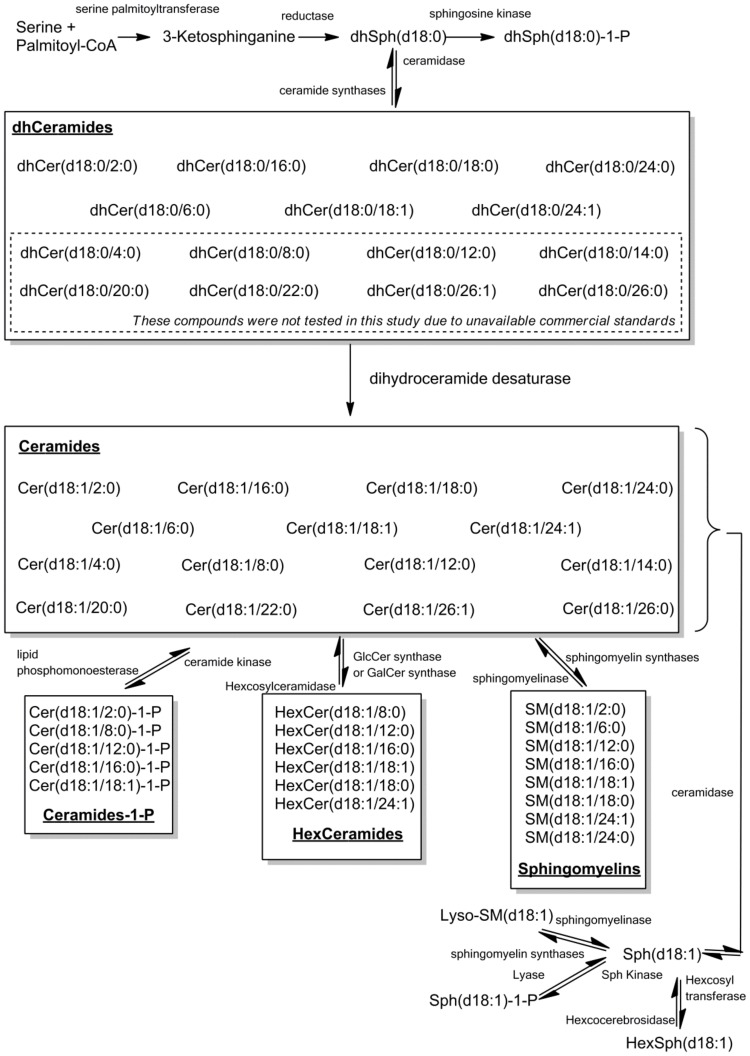
Metabolic pathways of sphingolipids.The sphingolipids examined in this study comprise the core components of sphingolipid metabolism.